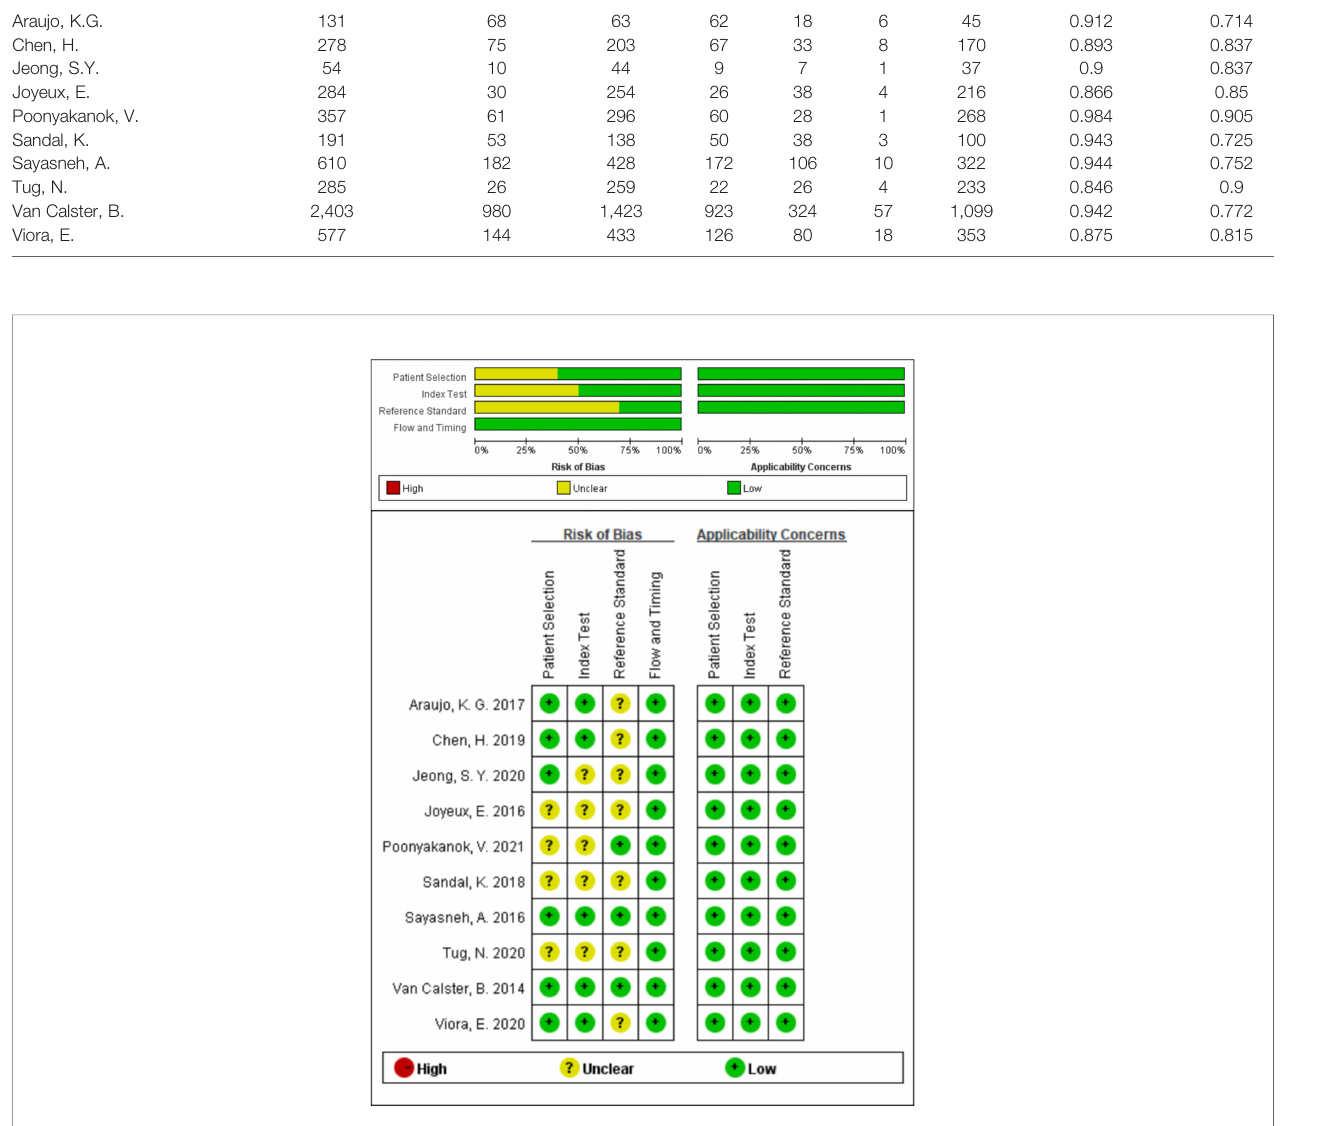
FIGURE 2 | Quality assessment by